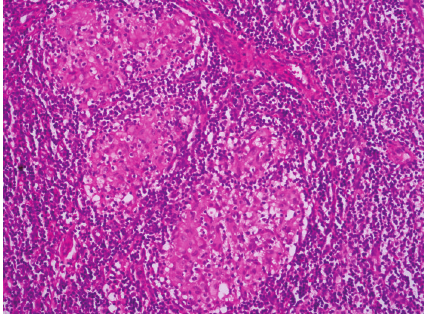
Figure 2: Photomicrograph of lymph node biopsy specimen show- ing caseating granulomas consistent with tuberculosis (hematoxylin and eosin stain; 20 fold magnification).